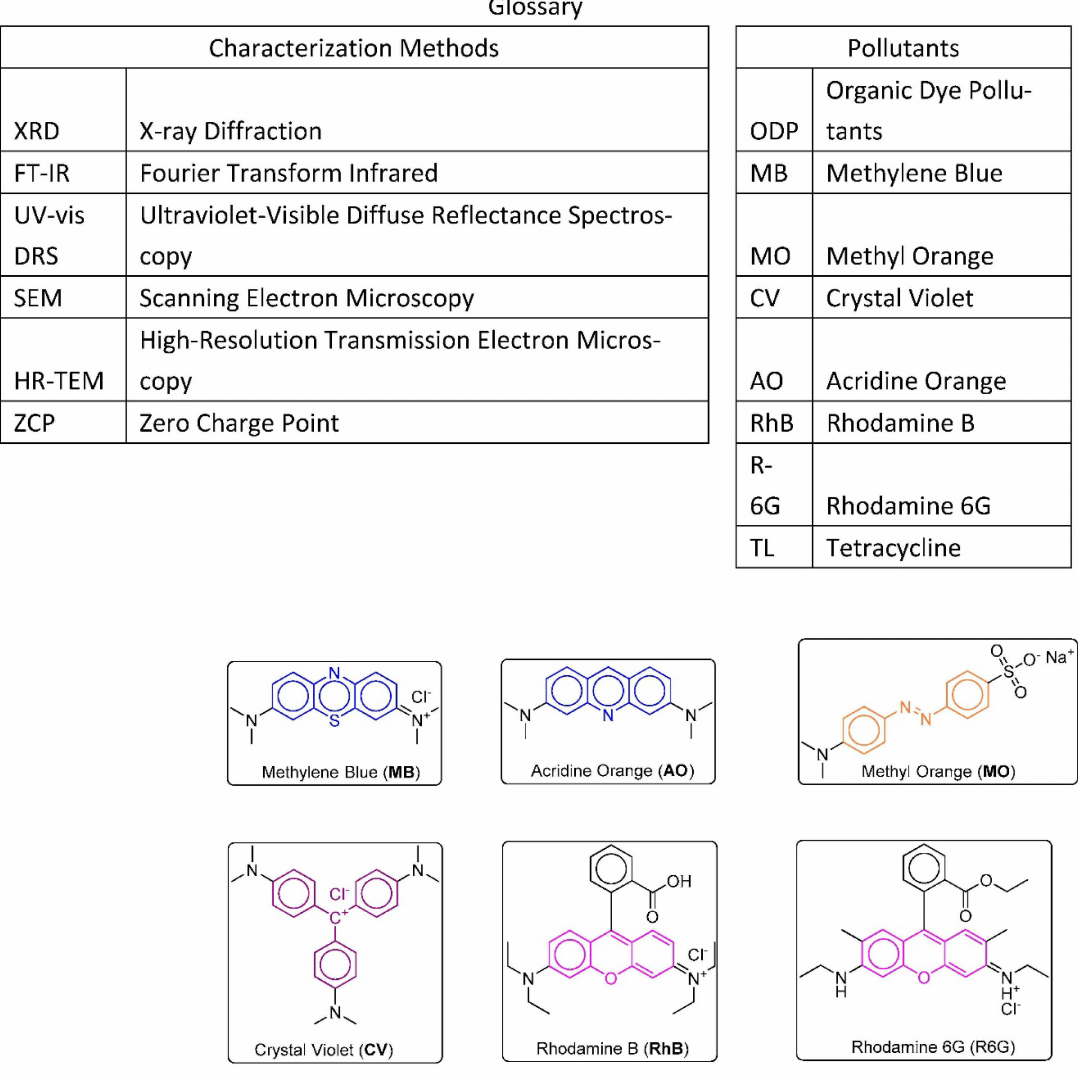
Figure 1. The structures of selected